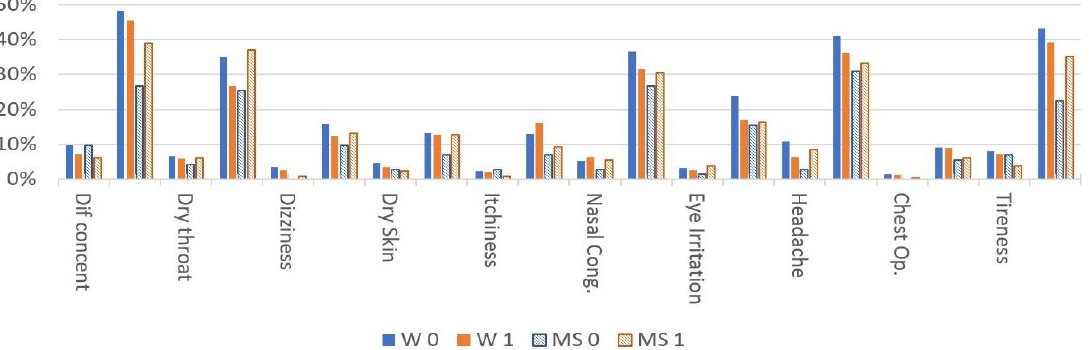
Figure 10. Average probability of reported symptoms by seasons (W is winter, MS is midseasons) and windows’ operation (0 is closed, 1 is open) (severe, left group; light perception, right group for each symptom).